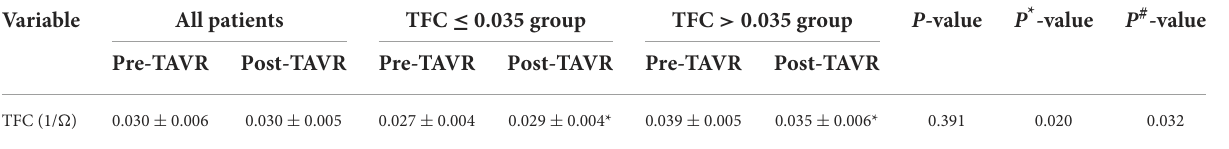
TABLE 6 Fluid content in all patients and subgroup patients divided by TFC = 0.035 1/ Ω before and after TAVR. Variable All